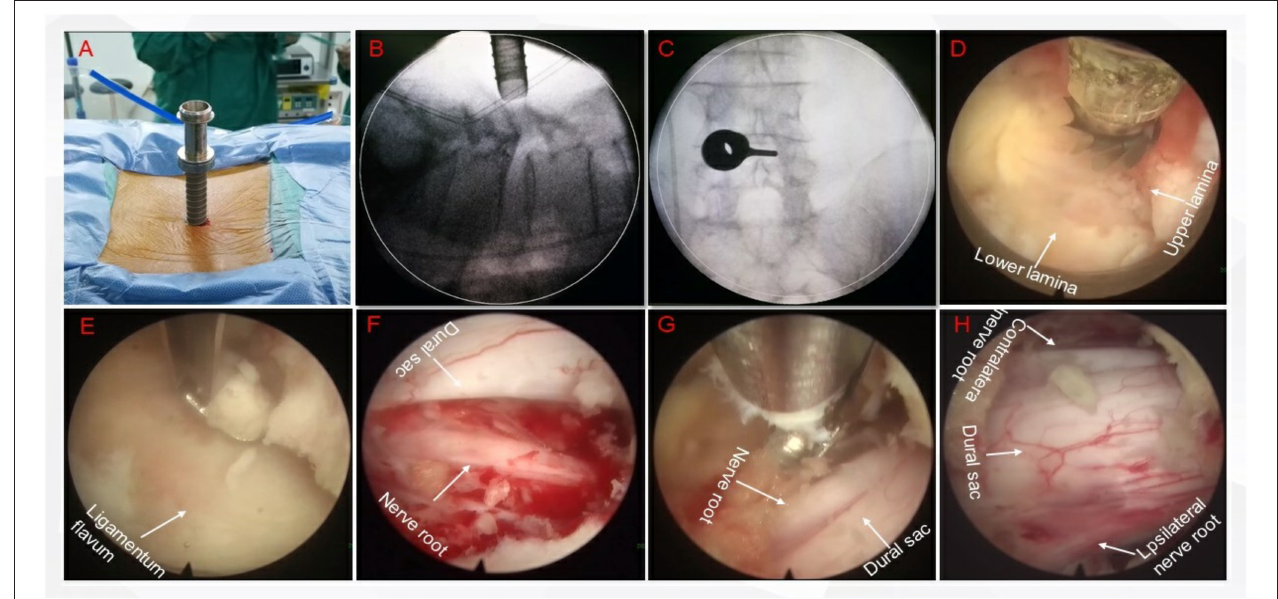
FIGURE 1 | A representative case. (A) Place the working channel; (B) Lateral X-ray fluoroscopy confirms that the channel is facing the intervertebral space; (C) Positive X-ray fluoroscopy confirms that the channel is located inside the facet joint; (D) Clean up the soft tissue on the surface of the lamina, confirm the lamina space and upper and lower lamina; E. Remove the lamina and expose the ligamentum flavum; (F) Decompression of the nerve root on the same side, ranging from the initial segment of the nerve root, down to the inner edge of the pedicle, explore the Ipsilateral nerve root canal to achieve at least 270 ◦ decompression of the nerve root canal; (G) Decompression of the contralateral nerve root; (H) After the decompression, the dural sac and bilateral nerve roots are visible.